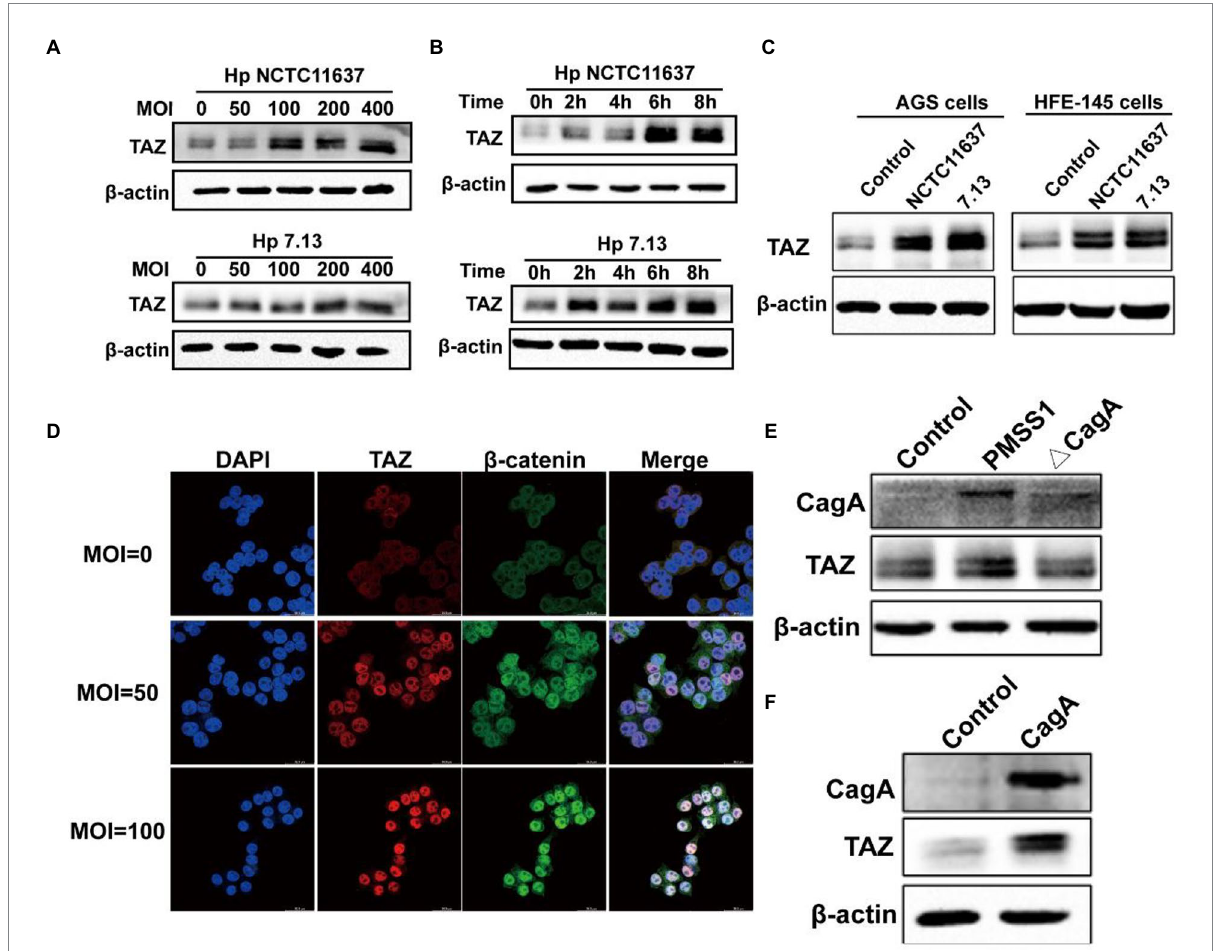
FIGURE 2 Helicobacter pylori infection promoted TAZ expression and nuclear localization. (A) Western blot for TAZ protein levels in human gastric epithelial cells infected with H. pylori NCTC11637 or 7.13 at different MOI for 6 h. (B) Western blot for TAZ levels in AGS cells treated with H. pylori strains at different time points at MOI of 100. (C) Western blot for TAZ levels in different gastric epithelial cells (AGS and HFE145) following infection with different H. pylori strains at MOI of 100 for 6 h. (D) Immunofluorescence staining for TAZ and β -catenin cellular localization after H. pylori NCTC11637 infection at different MOI for 6 h. (Magnification 400×, scale bars =30 μ m) (E) Western blot for TAZ expression in gastric epithelial cells infected with PMSS1 or its isogenic CagA- mutant. (F) Western blot for TAZ expression in gastric cells after transfection with the CagA expression